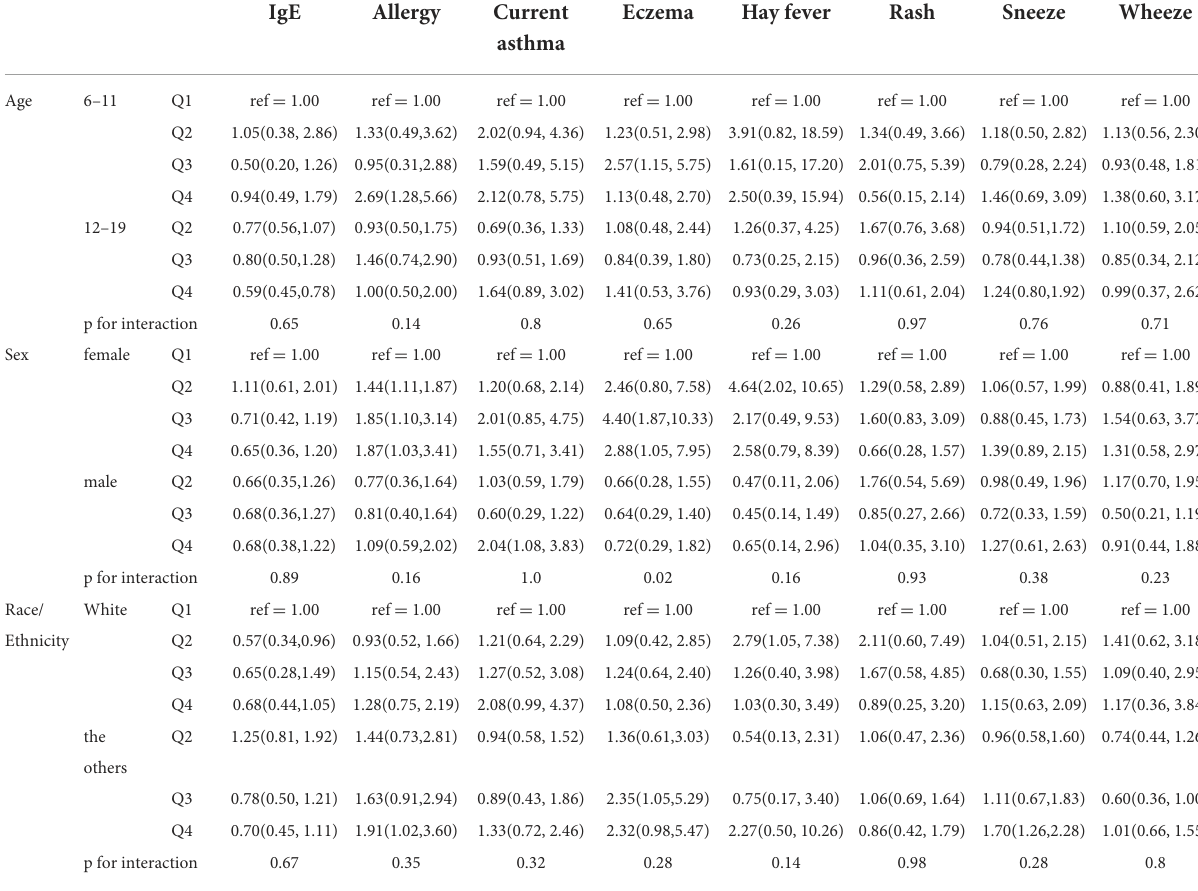
TABLE 3 The association between UPFs and allergic symptoms, stratified by selected subgroups in children. IgE Allergy Current Eczema Hay fever Rash Sneeze Wheeze asthma